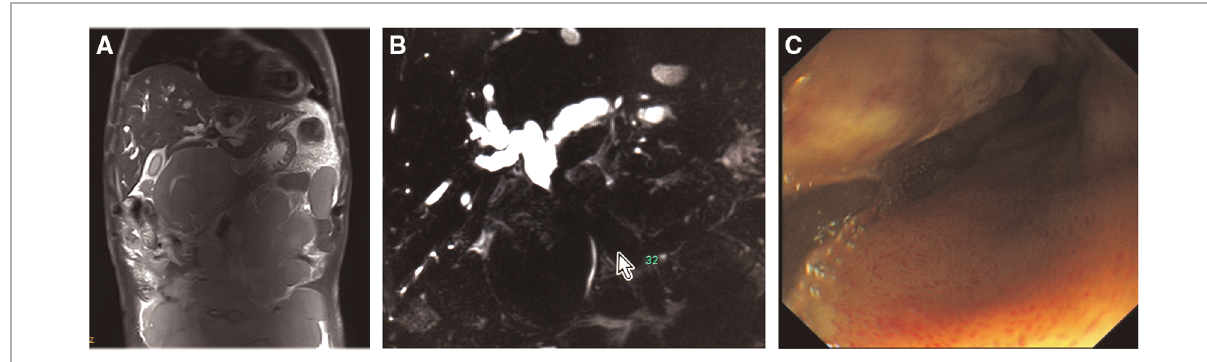
FIGURE 1 Initial fi ndings. ( A ) Abdominal magnetic resonance imaging showed massive lymphomatous lesions fi lling the peritoneal cavity. ( B ) Magnetic resonance cholangiopancreatography revealed an external compressive stricture in the superior middle common bile duct and dilation of the intrahepatic and extrahepatic ducts. ( C ) Endoscopic retrograde cholangiopancreatography showed ductal descending-junction stenosis of the duodenal bulb caused by lymphoma in fi ltration.